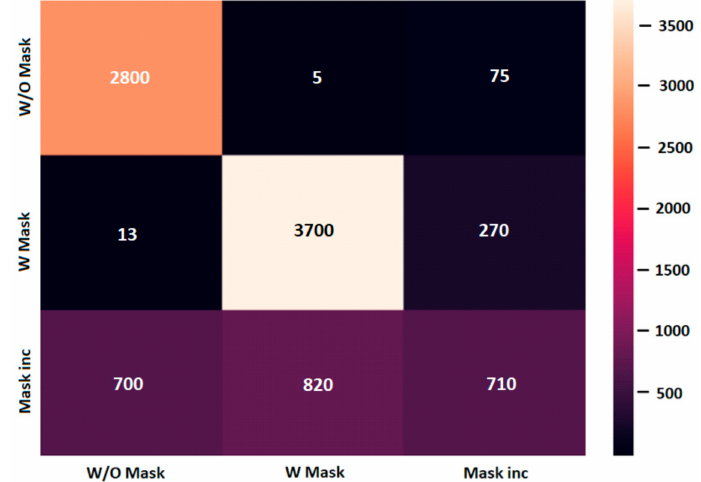
Figure 8. Confusion matrix for facemask